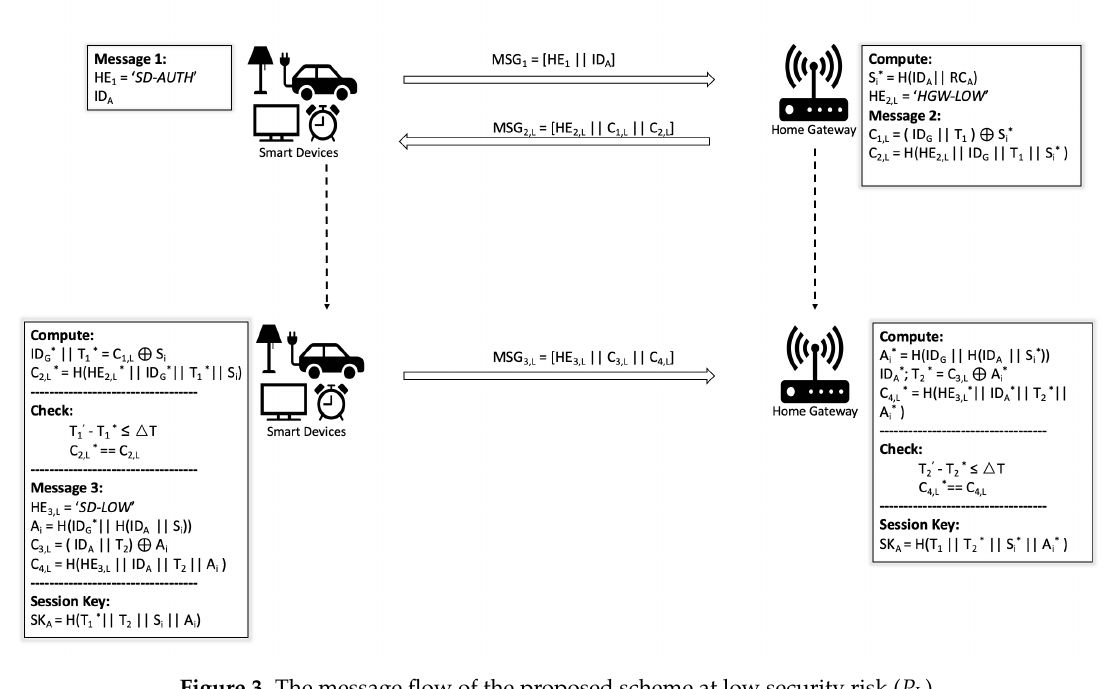
Figure 3. The message flow of the proposed scheme at low security risk ( P L ).